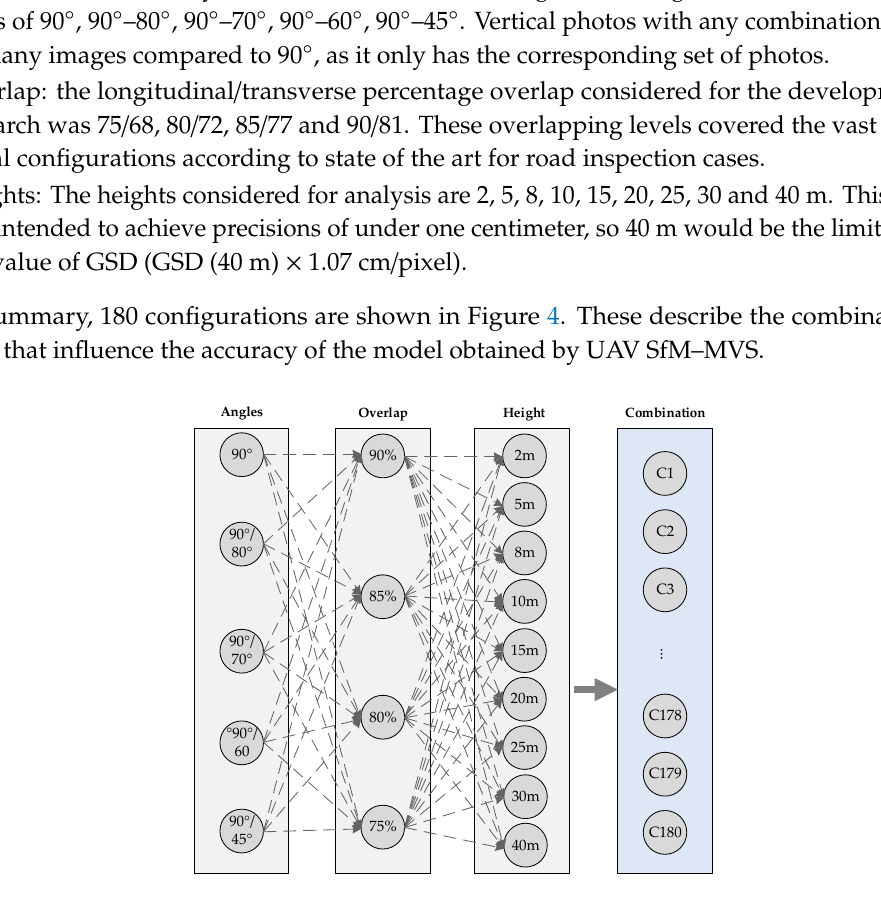
Table 2. UAV Phantom 4 Pro flight features. Resolution [MP]